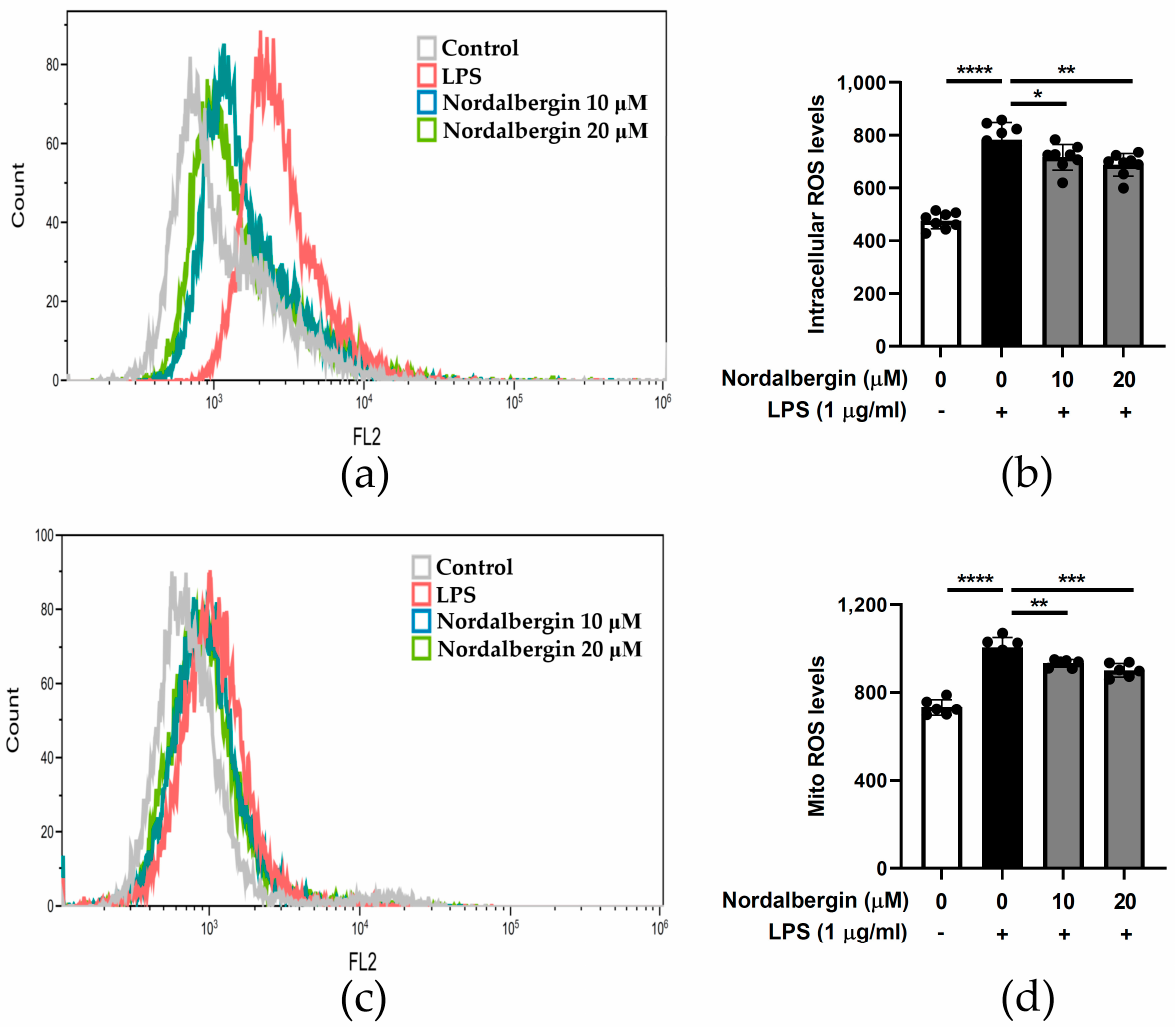
Figure 5. E ff ect of nordalbergin on the production of both intracellular and mitochondrial ROS by LPS-stimulated d BV2 cells. Cells were pretreated with various concentrations of nordalbergin for 30 min and then treated with LPS for 24 h. ( a ) Cells were stained with 1 µ Μ H 2 DCFDA and the levels of intracellular ROS analyzed using fl ow cytometry. ( b ) The quantitative results of intracellular ROS. ( c ) Cells were stained with 5 µ M MitoSOX red and levels of mitochondrial ROS analyzed using flow cytometry. ( d ) The quantitative results of mitochondrial ROS. Data are presented as mean ± SD (n = 6–8; * p < 0.05, ** p < 0.01, *** p < 0.001, **** p < 0.0001).